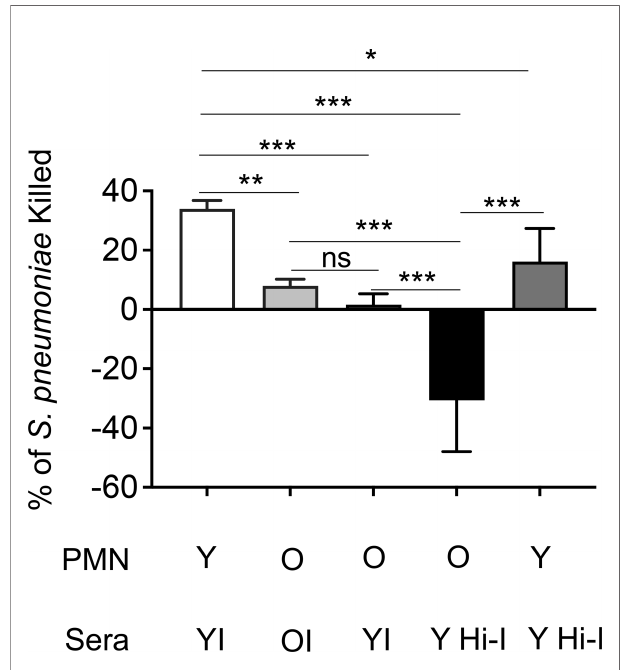
FIGURE 5 | The intrinsic antibacterial function of PMNs declines with age. PMNs were isolated from the bone marrow of naïve young and old male C57BL/6 mice and infected with S. pneumoniae pre-opsonized with young immune (YI), old immune (OI), or young heat inactivated immune (Y Hi-I) sera. The percentage of bacteria killed was then calculated in comparison to a no PMN control under the same treatment conditions. Data are pooled from four separate experiments (n=4 biological replicates) where each condition was tested in triplicate (n=3 technical replicates) per experiment. *, denotes signi fi cant differences as determined by One-way ANOVA followed by Tukey ’ s multiple comparisons test. * denotes p < 0.05, ** denotes p < 0.01, and *** denotes p < 0.001 . ns denotes not signi fi